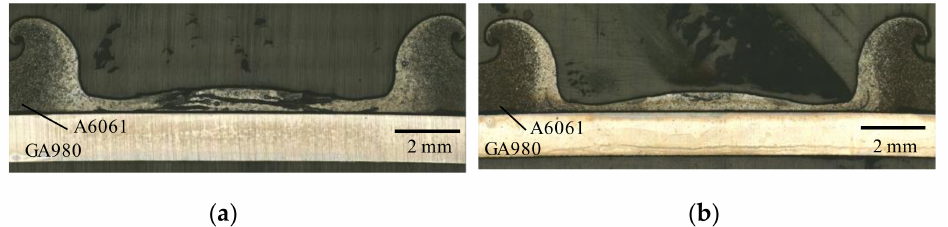
Figure 6. Optical microscope images of cross sections of the FSSW joints shown in Figure 5 after etching treatment. ( a ) Welding time: 9 s and ( b ) welding time: 10 s.